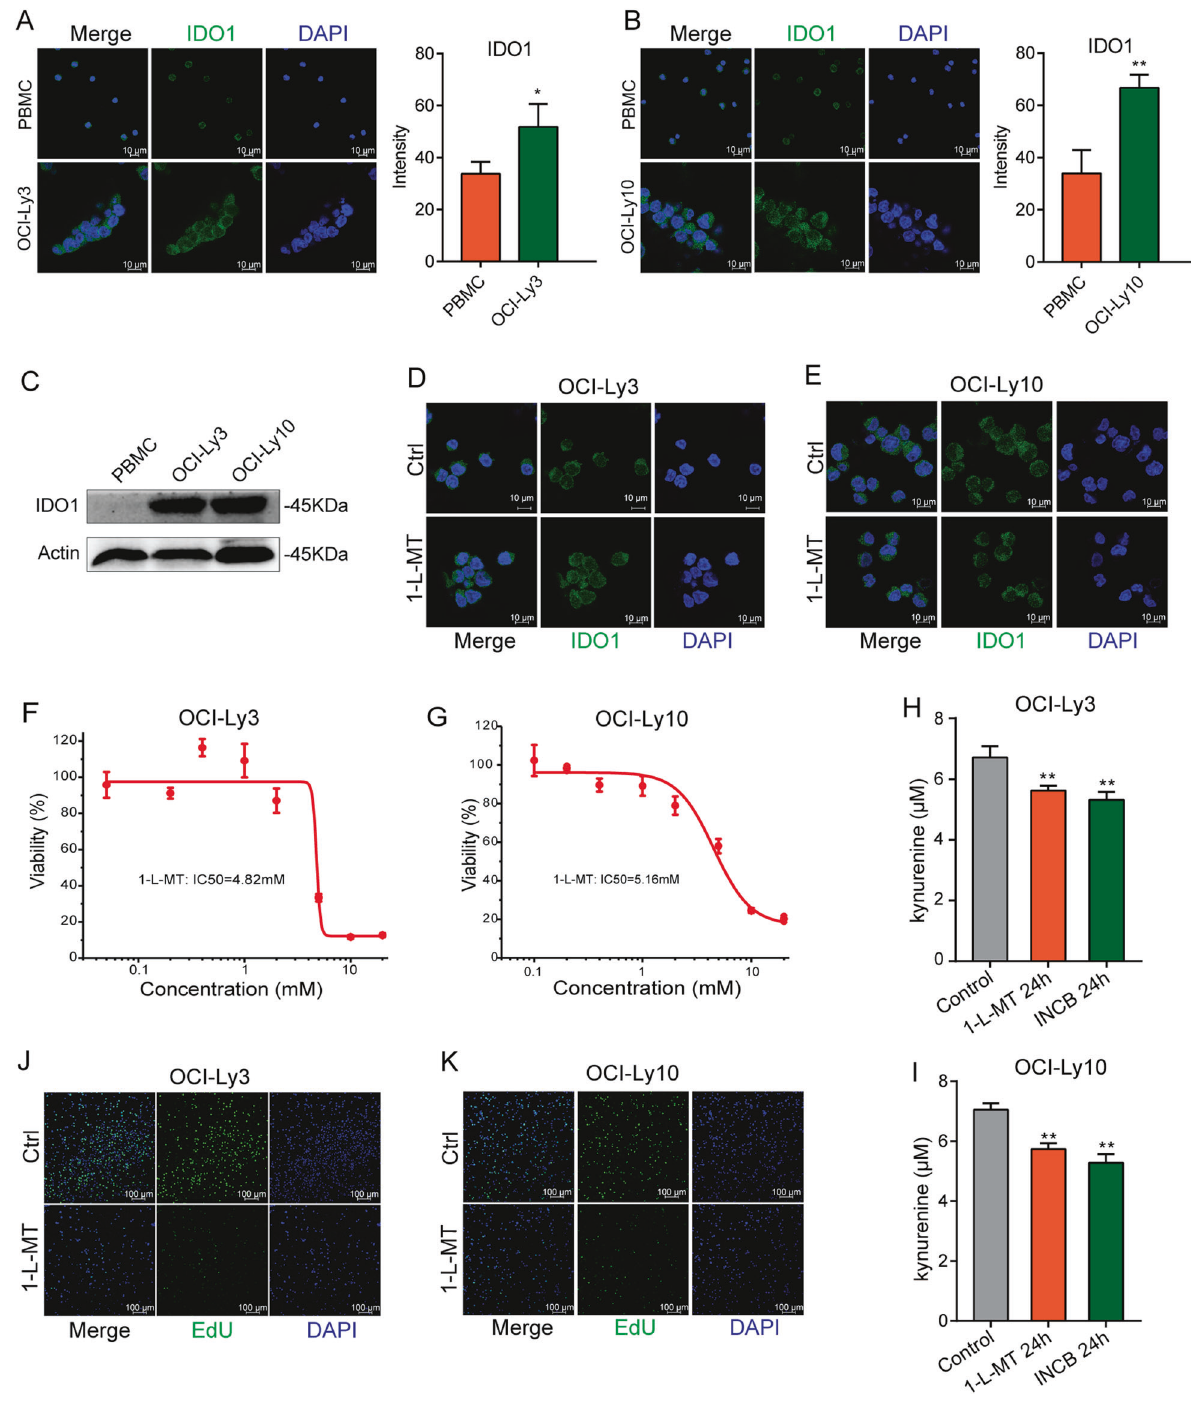
Fig. 3 IDO1 inhibitor suppressed DLBCL cell growth. A , B Immuno fl uorescence staining for IDO1 expression in PBMCs, OCI-Ly3 cells, and OCI-Ly10 cells (× 630, scale bar, 10 μ m). C WB analysis of IDO1 protein expression in OCI-Ly3, OCI-Ly10, and PBMCs. D, E 1-L-MT competitively inhibited the activity of IDO1 and did not affect the protein expression level of IDO1 by immuno fl uorescence assay (× 630; scale bar, 10 μ m). F, G Cell viability was determined using CCK-8 after OCI-Ly3 and OCI-Ly10 cells were treated with various concentrations of 1-L-MT for 48 h. H,I OCI-Ly3 and OCI-Ly10 cells were stimulated with 5 mM 1-L-MT or 50 μ M INCB for 24 h, and then ELISA was used to determine the KYN acid secretion. J,K EdU staining of 5 mM 1-L-MT-treated and control OCI-Ly3/OCI-Ly10 cells (×100; scale bar, 100 μ m). Statistical analysis was analyzed with a two-sided student ’ s t-test. * P < 0.05 and ** P < 0.01. The above fi ndings indicated that IDO1 might play a potential the results demonstrated that IDO1 protein levels were elevated in role in promoting DLBCL. To investigate the possible role of IDO1 OCI-Ly3 and OCI-Ly10 cells compared with PBMCs (Fig. 3C). Taken in DLBCL cells, an IDO1 inhibitor, 1-L-MT was used. As a together, these fi ndings indicated that IDO1 was highly expressed tryptophan analog, 1-L-MT can competitively inhibit the activity in DLBCL cells. Cell Death and Disease (2022)